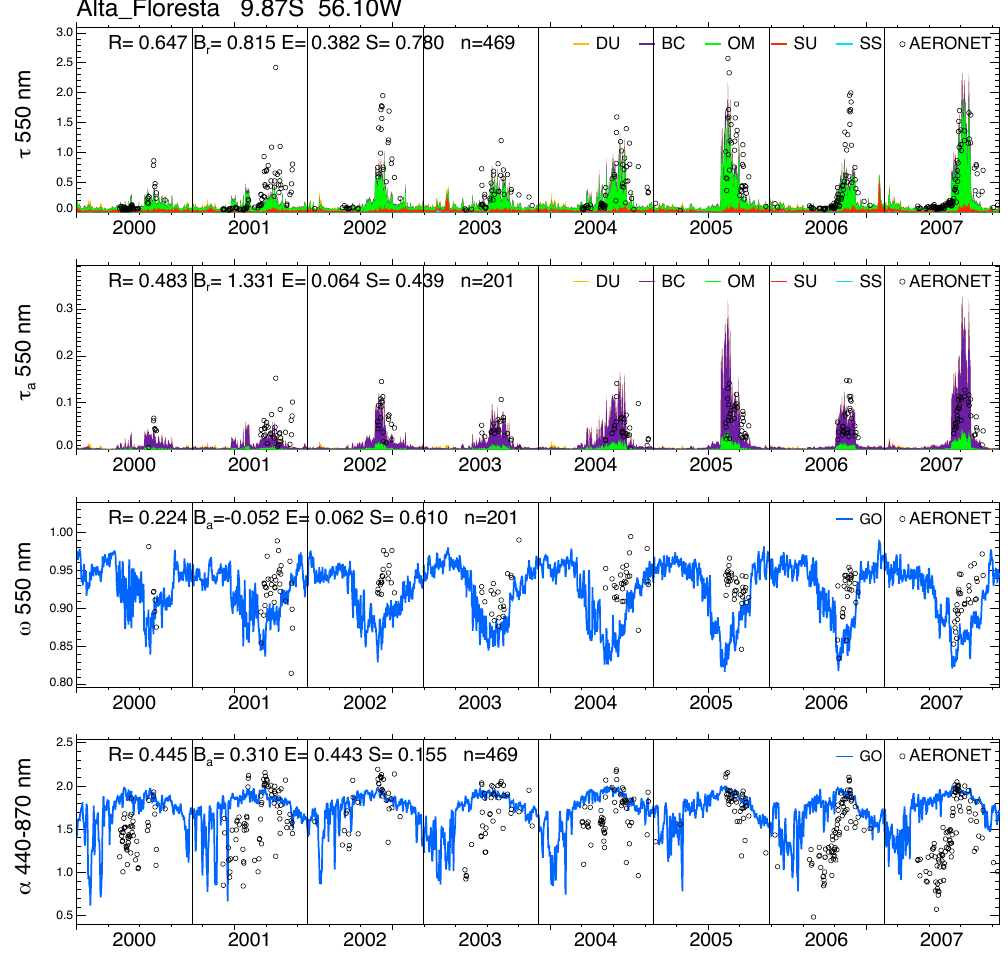
Fig. 5f. Same as Fig. 5a but for Alta Floresta in Brazil.